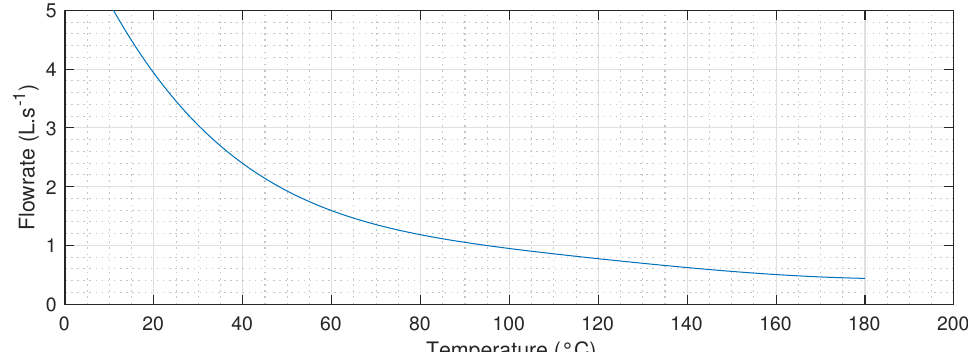
Figure 8. Minimum allowed flow of the heat transfer fluid.